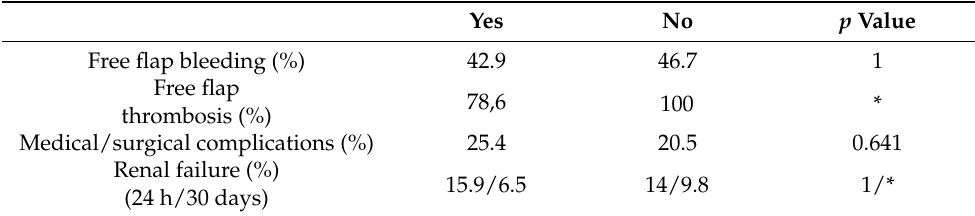
Table 6. Vasopressors and